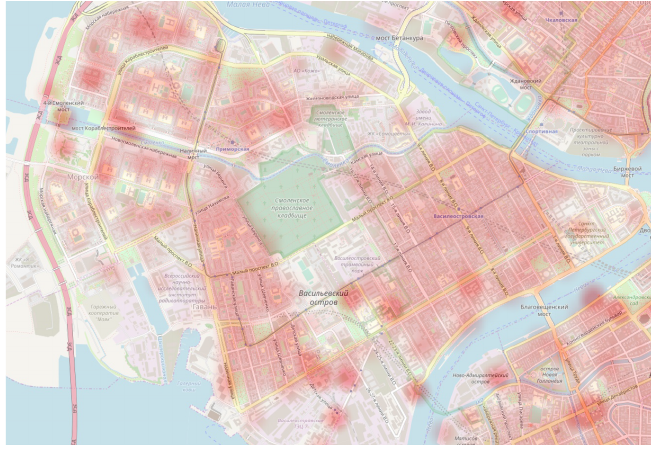
Figure 4. Assessment of the density of AH + individuals in Vasilyevsky island, St Petersburg, using the interpolated